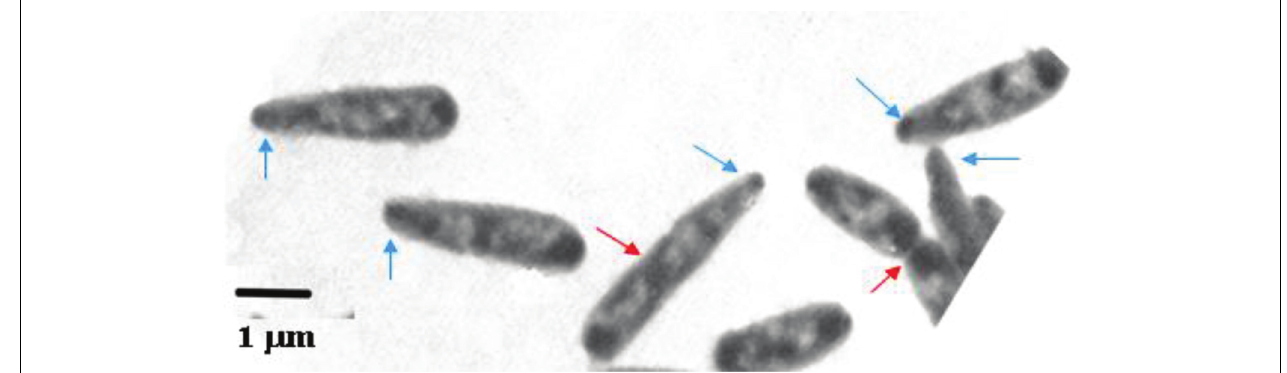
show up as electron-transparent regions in the air-dried cells, flattened by surface tension (cf. Woldringh et al., 1977). Red arrows indicate constriction sites, blue arrows, tapered tips.